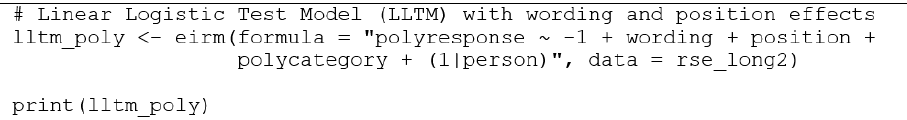
Figure 15. Estimate the LLTM for polytomous items and print the model output.